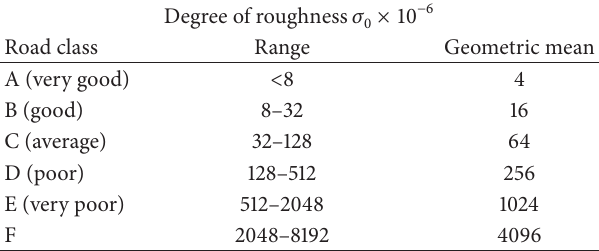
Table 1: Road roughness values classified by ISO [4,